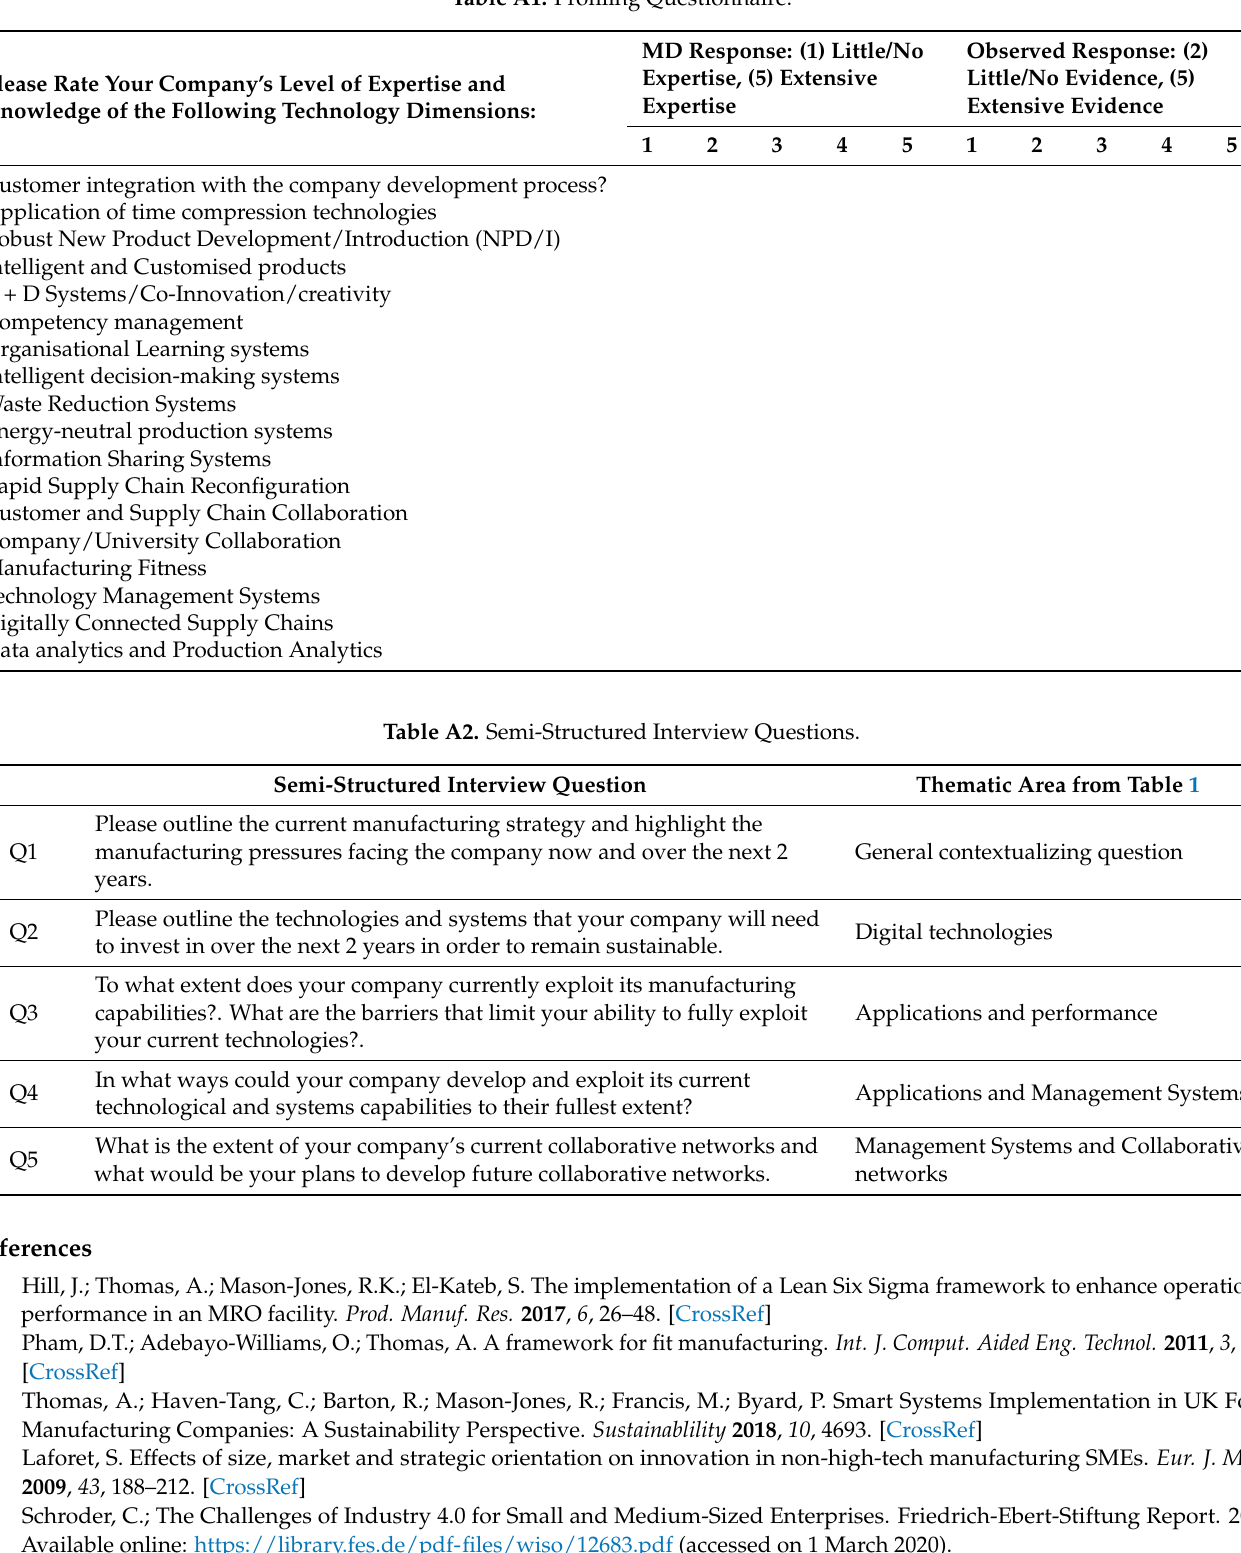
Table A1. Profiling Questionnaire.